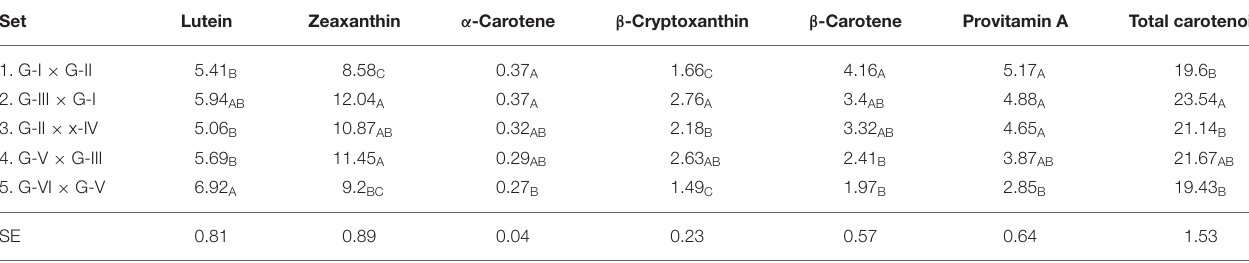
TABLE 2 | Mean carotenoid concentrations ( µ g/g) for the five mating sets. Set